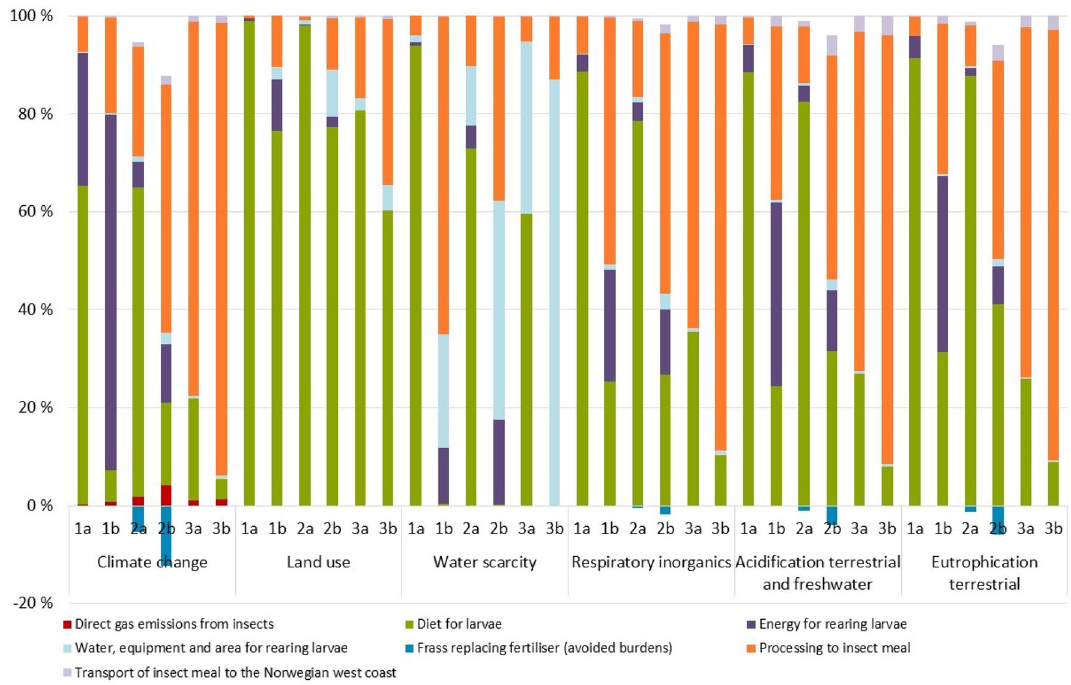
Fig. 3 Contribution analysis for the environmental performance of rearing and processing insects into insect meal (for protein delivered to the west coast of